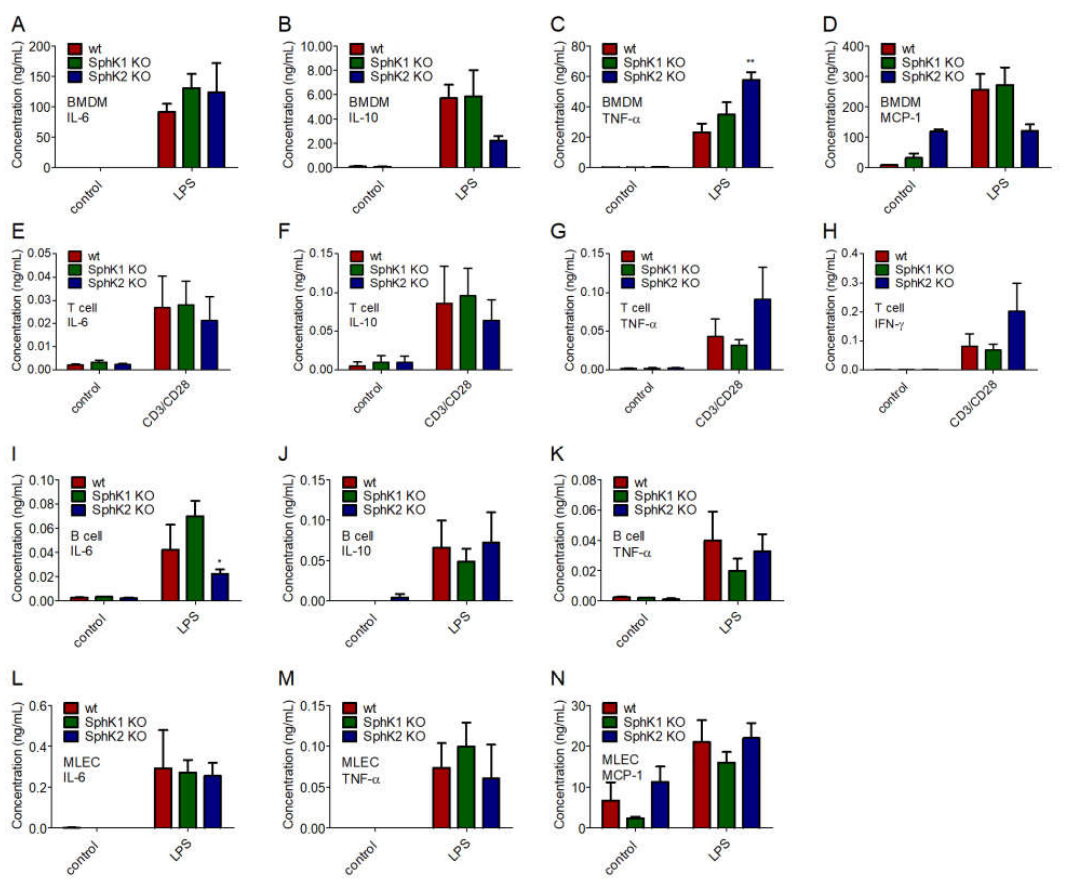
Figure 5. Concentration of ( A , E , I , L ) IL-6, ( B , F , J ) IL-10, ( C , G , K , M ) TNF- α , ( D , N ) MCP-1 and ( H ) IFN- γ in ( A – D ) BMDM, ( E – H ) T cells, ( I – K ) B cells and ( L – N ) MLEC unstimulated (control) and 24 h after stimulation with 10 µ g/mL LPS or α -CD3 and α -CD28 antibodies. Significances were calculated between cells derived from wt mice and those derived from SphK1/2 deficient mice in the respective control or LPS-treated groups using two-way ANOVA with Bonferroni posttests, n ≥ 3, * p < 0.05, ** p <